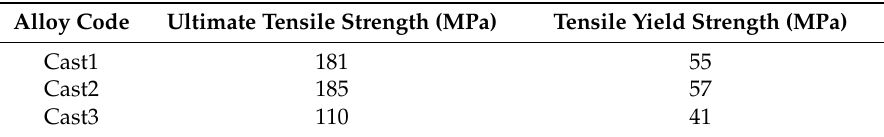
Table 4. Tensile properties of the cast Mg-1Mn-2Zn-xNd